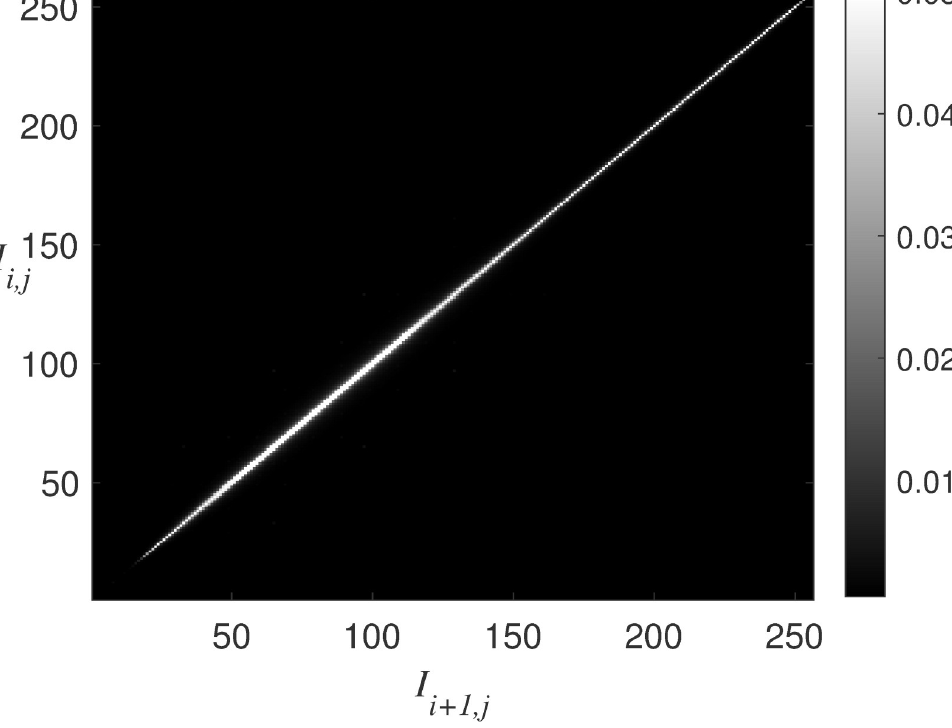
Fig 1. The probability distribution of adjacent pixel pair ( I i , j , I i +1, j ).